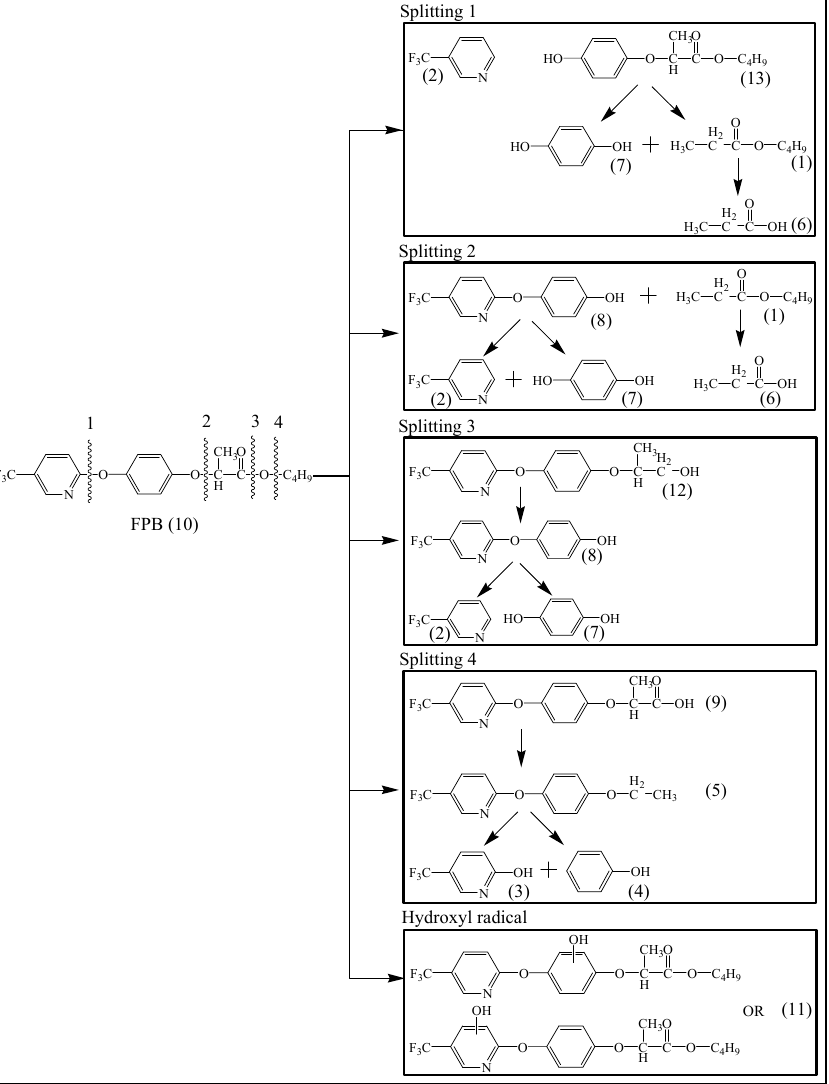
Figure 6. The proposed photocatalysis degradation pathways of FPB by nano-TiO 2 .